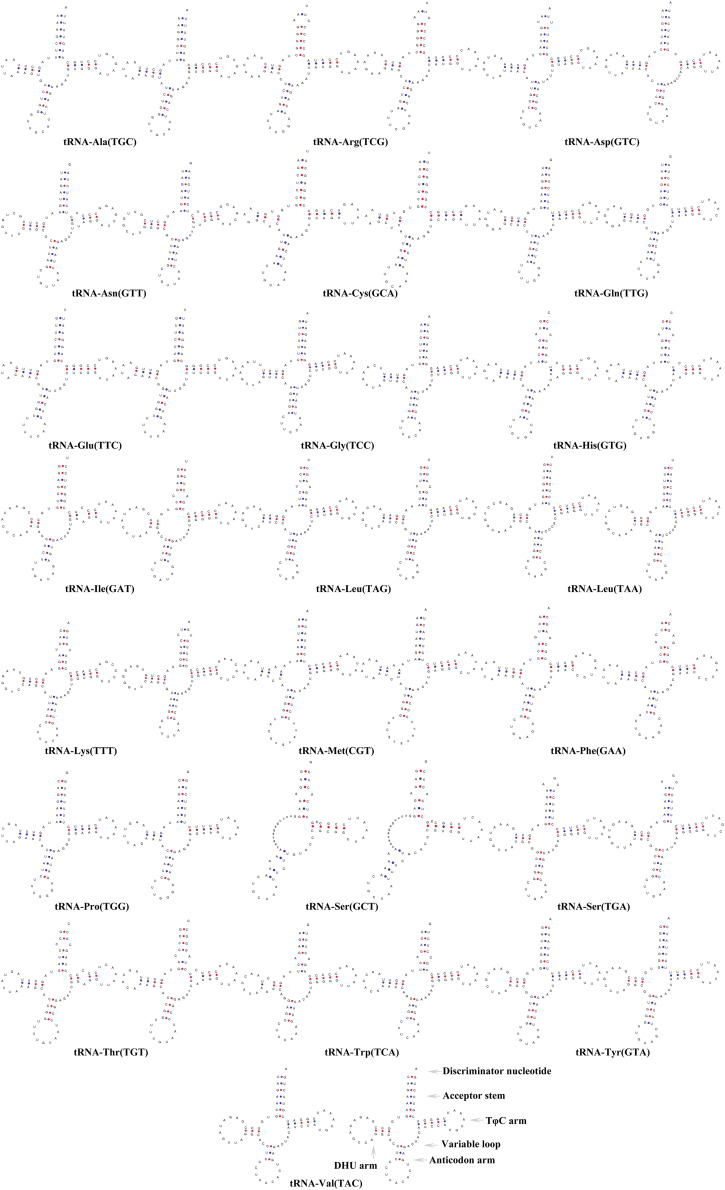
Secondary structures of the 22 transfer RNA genes of two Characidae species [Hemigrammus erythrozonus (left) and Hyphessobrycon amandae (right)].